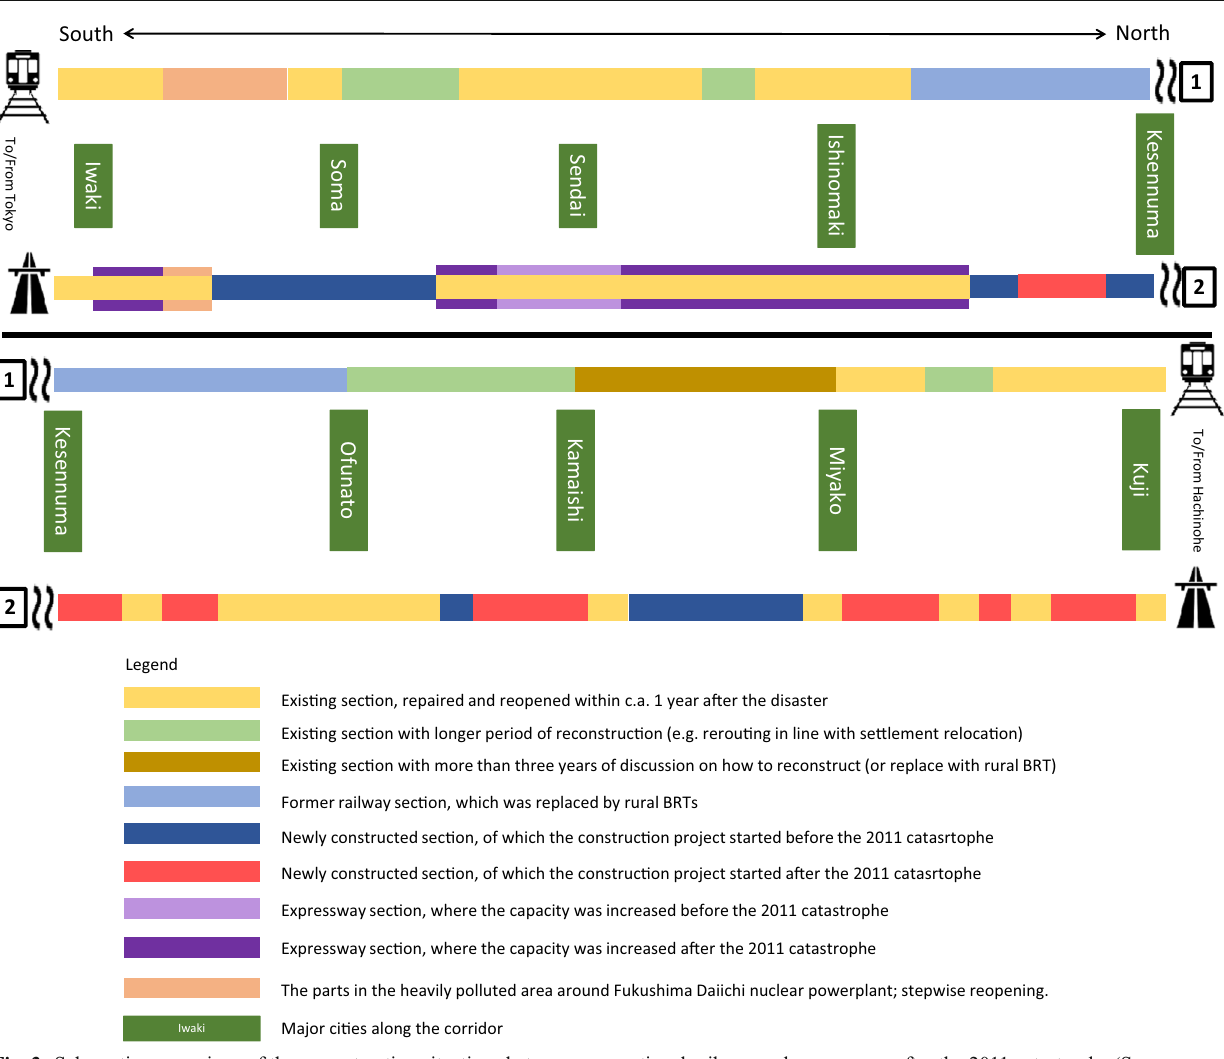
B Reconstruction supporting expressways ^ as of March 2015, Source: MLIT Name of expressway In operation [km] Under construction [km] Section approved in 2011